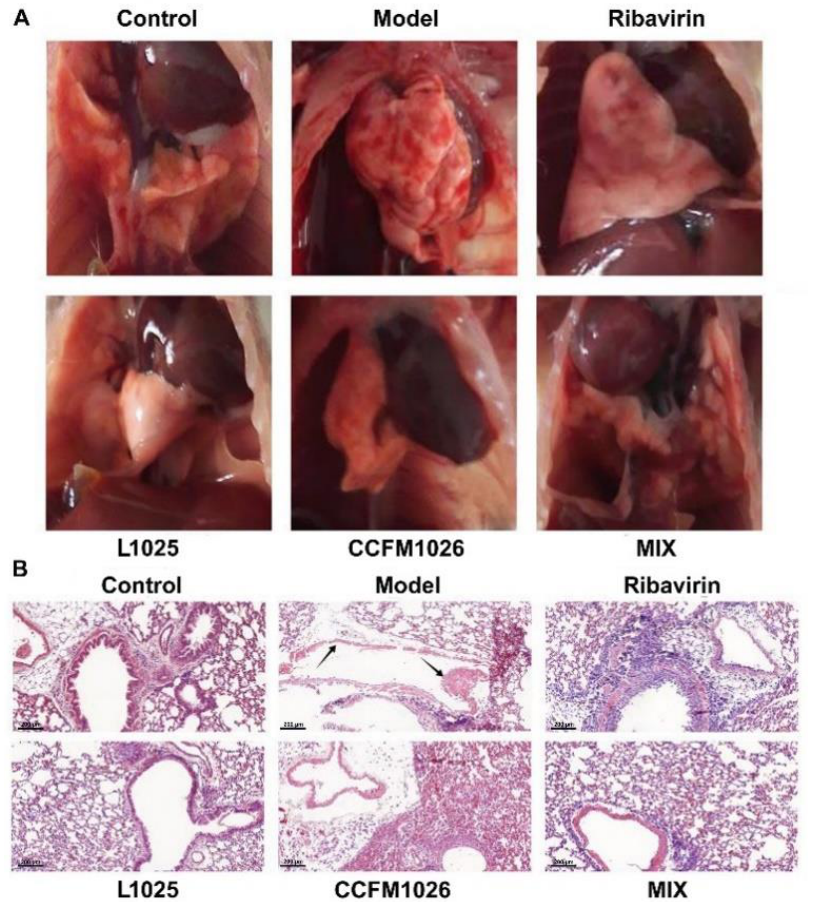
Figure 3. Pathological features of lung. ( A ) Pathological pictures of the lung. ( B ) HE (hematoxylin and eosin) staining for the lung sections; the arrows indicate inflammatory infiltration and abruption of the bronchial epithelium. Scale bar = 200 μm, original magnification = ×400.